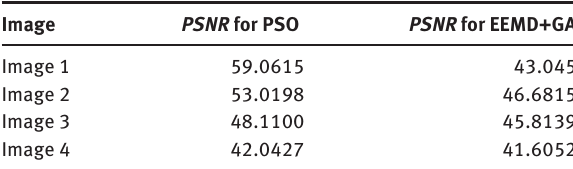
Table 1. PSNR for the Four Test Images.